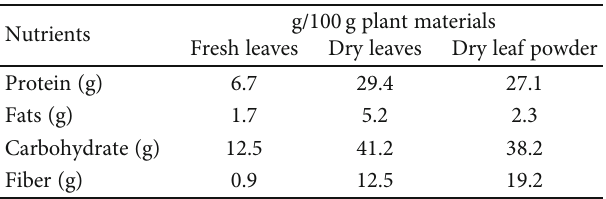
Table 2: Proximate pro fi les of Moringa fresh leaves, dry leaves, and leaf powder.